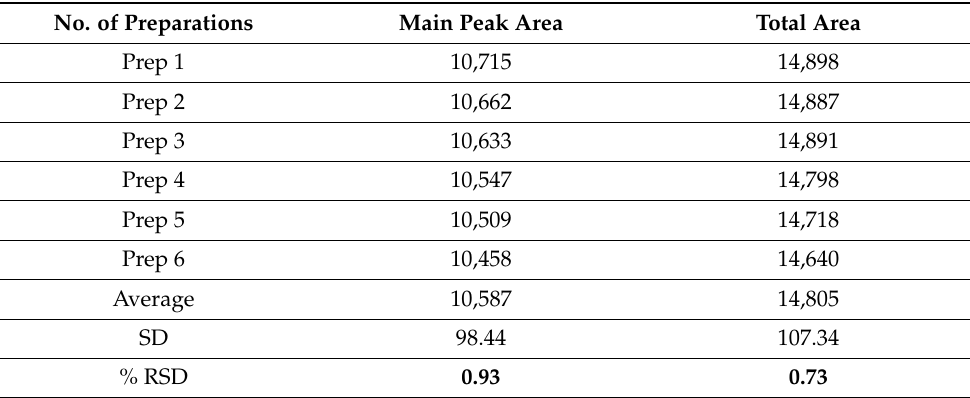
Figure 8. Accuracy data chromatogram with 50, 100 and 150% of loading amount. Table 4. Qualification data set for repeatability set 1 experiment using 6 different samples of 3.0 mg/mL concentration.